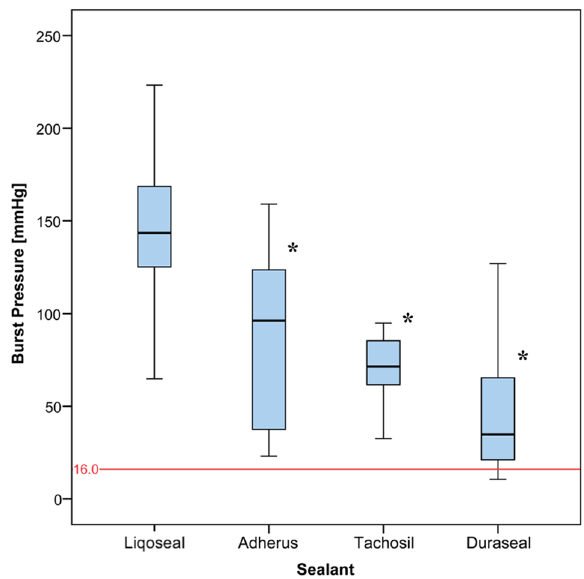
Fig. 5 Mean acute burst pressure test results concerning the sealants used in the cranial model. The red line indicates the mean physiolo- gical intracranial pressure. * indicates signi fi cant difference compared with